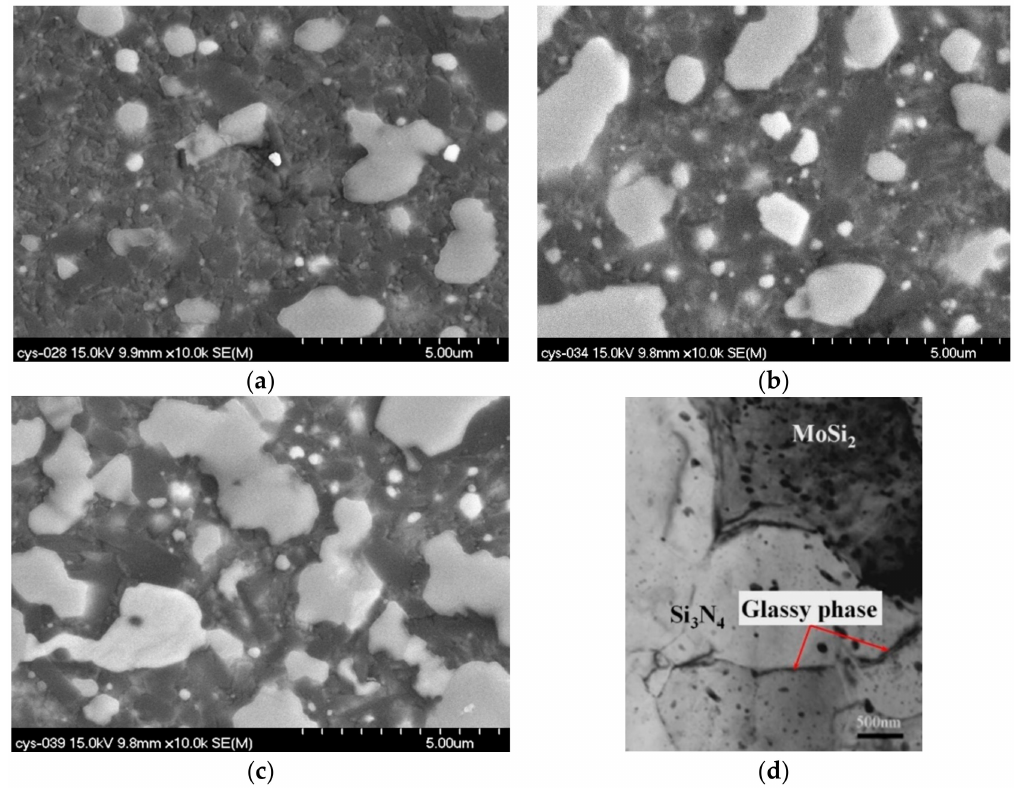
Figure 5. High magnification backscattering SEM of the Si 3 N 4 -MoSi 2 composites ( a ) Si 3 N 4 -30 wt % MoSi 2 ; ( b ) Si 3 N 4 -45 wt % MoSi 2 ; ( c ) Si 3 N 4 -60 wt % MoSi 2 , and ( d ) TEM